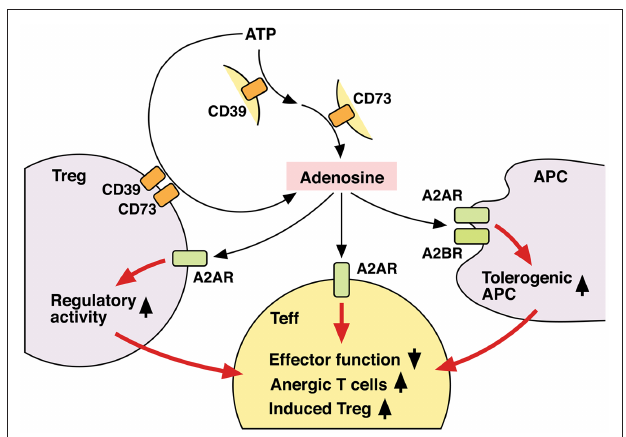
FIgure 3 | Mechanisms of T cell regulation by extracellular adenosine. Extracellular adenosine can be produced by activities of CD39 and CD73 on cell surface. And its interaction with A2AR directly inhibits T cell activation. Tregs express both CD39 and CD73 at high levels and use adenosine for their immunoregulatory activity. Adenosine enhances immunoregulatory activity of Tregs via A2AR signaling. A2AR signaling in effector T cells may induce differentiation into Tregs. There might be a positive feedback loop between adenosine and Treg-dependent immunoregulation. Moreover, adenosine increases tolerogenic APCs, which are poor stimulators of effector T cells. Thus, adenosine suppresses T cell immunity both by directly inhibiting activation of effector T cells and indirectly by producing the immunosuppressive environment. By employing different mechanisms, the immunosuppression by adenosine might be quickly effective and